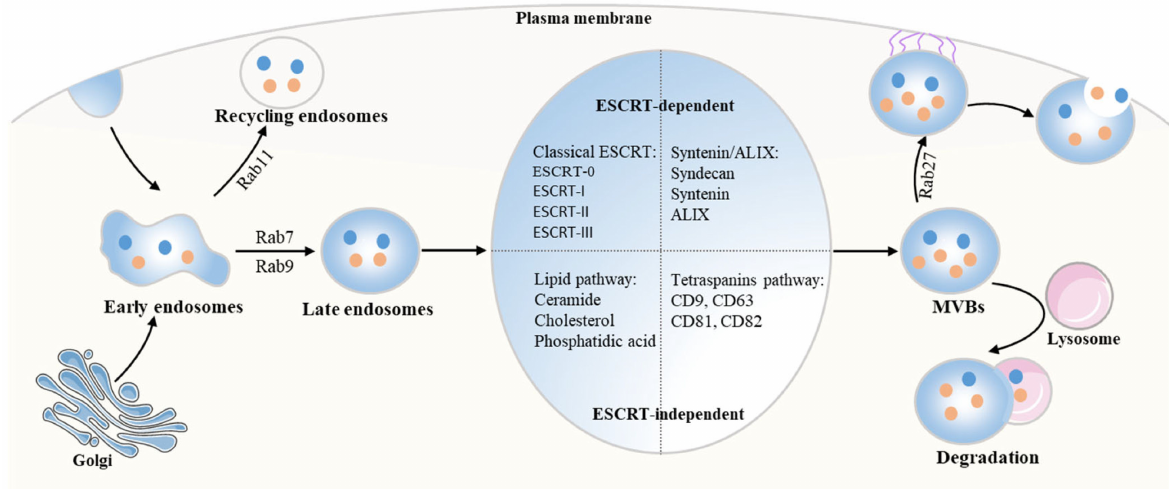
Figure 1. Schematic representation of exosome biogenesis. The early endosomes (EEs) are formed through the invagination of the plasma membrane, in which the transmembrane proteins are sorted to late endosomes by Rab7 and Rab9. Then, the EEs further generate intraluminal vesicles (ILVs), which lead to the formation of multivesicular bodies (MVBs). There are two types of molecular mechanisms involved in the process: Endosomal Sorting Complex Response for Transport (ESCRT)—dependent or independent pathways. After that, with the help of Rab27, the MVBs dock and fuse with the plasma membrane to release it as exosomes. Additionally, the MVBs can also fuse with lysosomes for degradation and recycling. Acronyms: Rab7, Ras-related protein 7; Rab9, Ras-related protein 9; ILVs, intraluminal vesicles; MVBs, multivesicular bodies; ESCRT, Endosomal Sorting Complex Response for Transport; Rab27, Ras-related protein